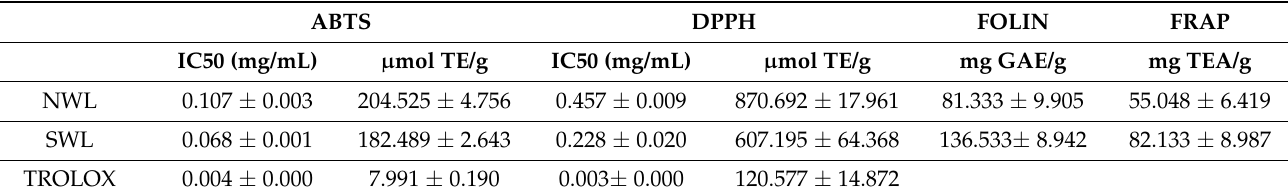
Table 8. Results of the antioxidant